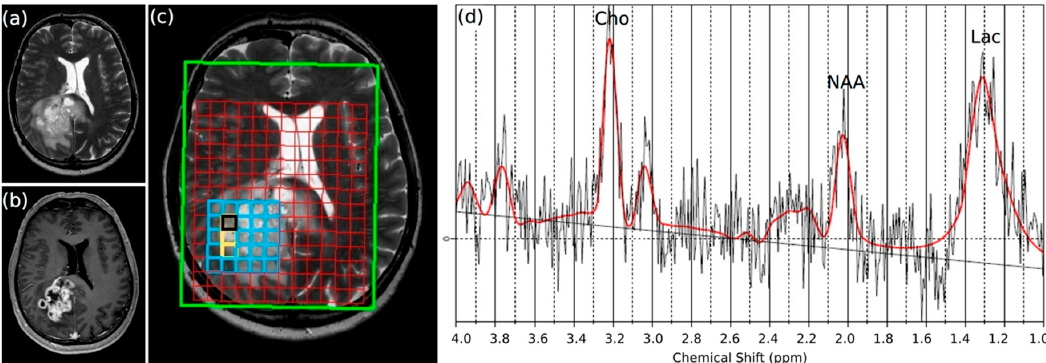
Figure 1. Representative magnetic resonance (MR) examination of a glioblastoma multiforme (GBM) patient. The same slice is shown in different weighted sequences. ( a ) T2-weighted image; ( b ) T1-weighted image after administration of the i.v. contrast agent Gadolinium; ( c ) T2-weighted image with the grid of the multi voxel magnetic resonance spectroscopic imaging (MRSI); the black square highlights the spectrum shown in part ( d ); ( d ) spectrum of a voxel in the contrast-enhancing part of the GBM analyzed with a linear combination model (LCModel). Besides an elevated choline-peak at 3.2 ppm (Cho) and a decreased NAA ( N -acetyl aspartate)-peak at 2.0 ppm, an elevated lipid/lactate-peak (Lac) at 1.3 ppm was detected.